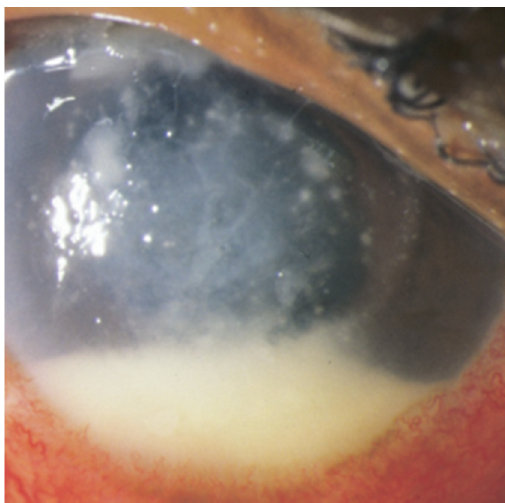
Figure 1. Photograph demonstrating Fusarium oxysporum endophthalmitis which developed 27 days after minor trauma with organic matter to the right eye. A hypopyon and anterior chamber fungal infiltrates are seen in the setting of a multifocal, feathery-edged corneal infiltrate. Adapted from